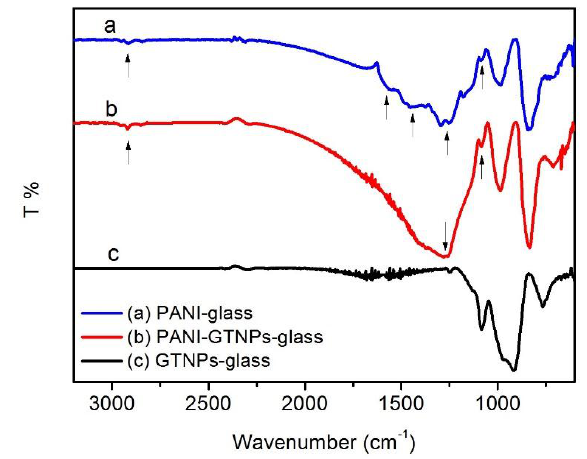
Figure 2. Attenuated total reflection-Fourier transform infrared (ATR-FTIR) spectra of PANI ( curve a ); PANI-GNPs ( curve b ); and GNPs ( curve c ) on glass. The three curves are offset for comparison. The peaks are indicated by arrows.